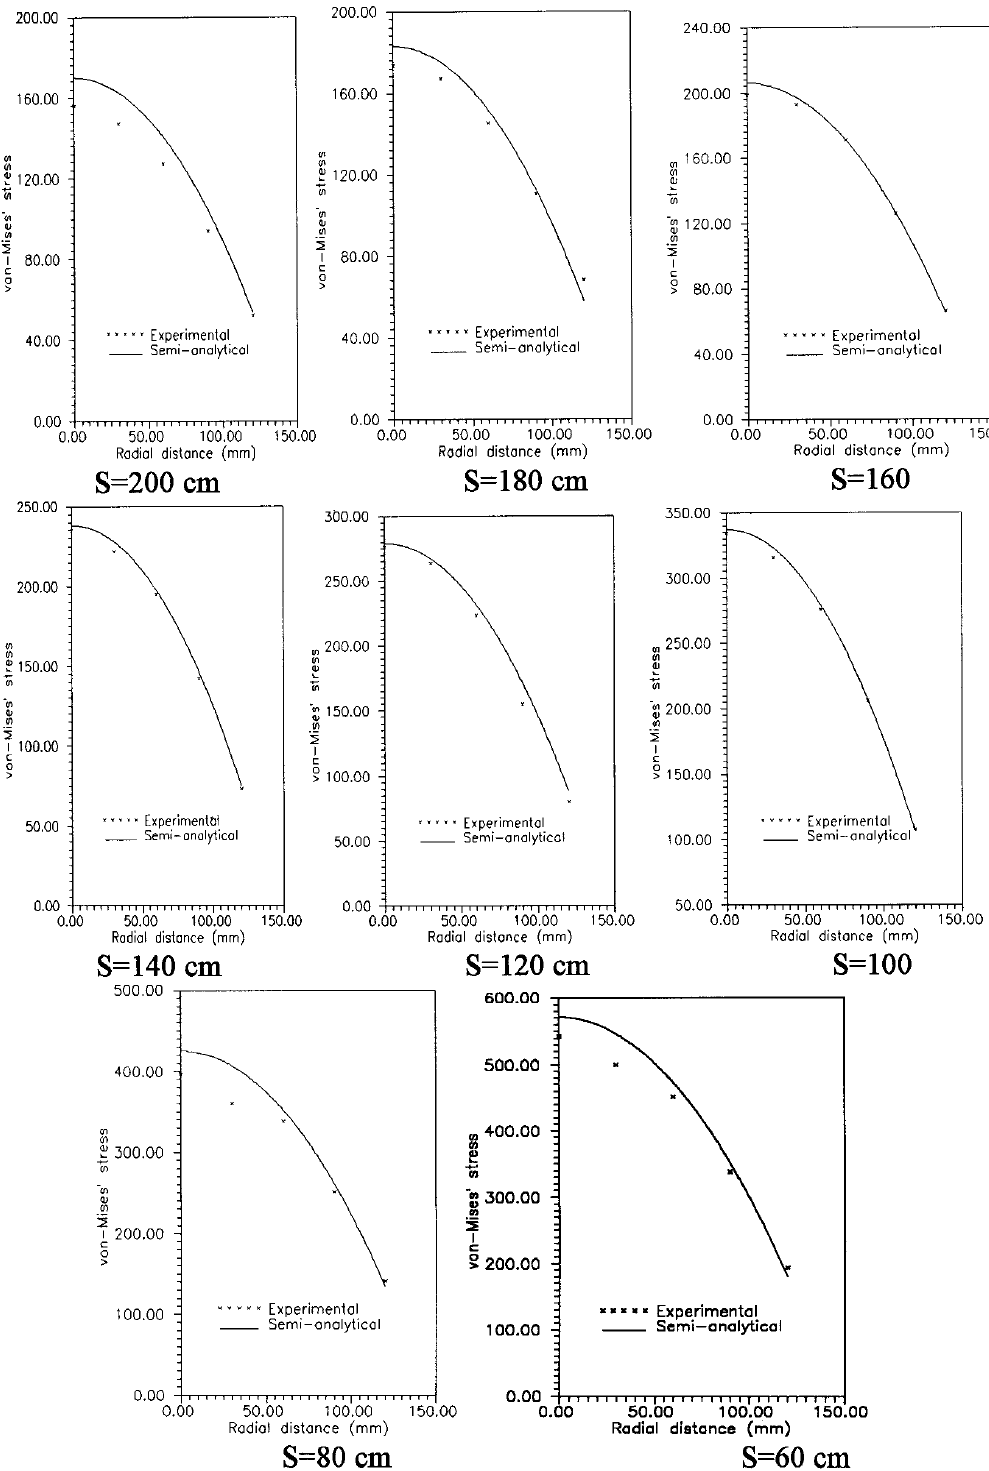
Fig. 8. Variation of von-Mises’ stress along the radius of the circular plate. S is stand